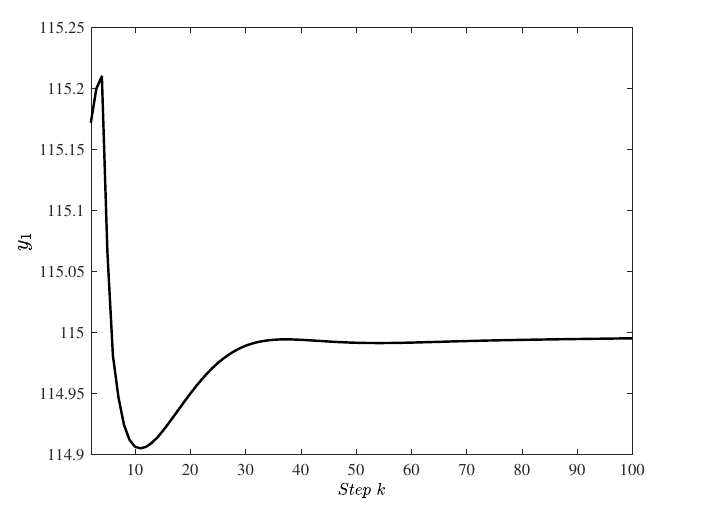
Figure 10. Control inputs of MPC.